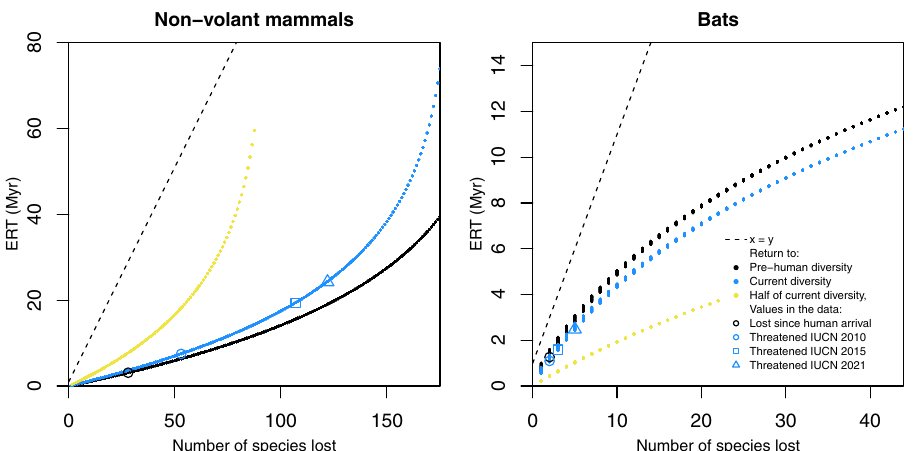
Fig.4|Timeittakestorecoverspeciesatdifferentstagesoftheislanddiversity curve. Relationshipbetween ERTand number of species to be recovered based on 10,000 simulations with different starting diversities (i.e. assuming different